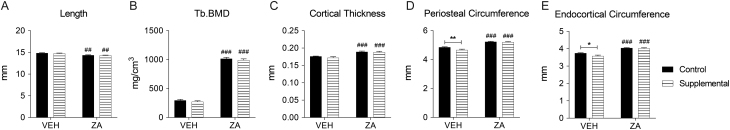
Vitamin A effects on cortical bone were not observed in the presence of bisphosphonate treatment. Femur (A) length, (B) trabecular bone mineral density (Tb. BMD), (C) cortical bone thickness, and (D) periosteal and (E) endocortical circumference as measured by pQCT. Similar results observed in tibia. Values given as mean ± s.e.m., n = 10/group. Student’s t-test; Vehicle (VEH): control vs supplemented, and Zoledronic acid (ZA): control vs supplemented *P < 0.05, **P < 0.01. Student’s t-test ZA treatment vs respective VEH control, #P < 0.05, ##P < 0.01, ###P < 0.001. 2-way ANOVA for interaction, P > 0.05.